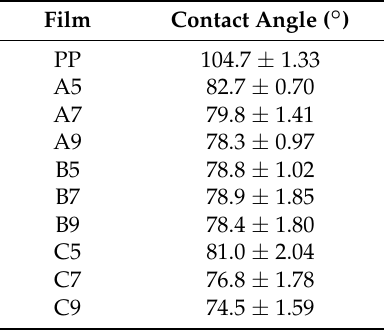
Table 1. Values of contact angles for PP film and PP/chitosan films.